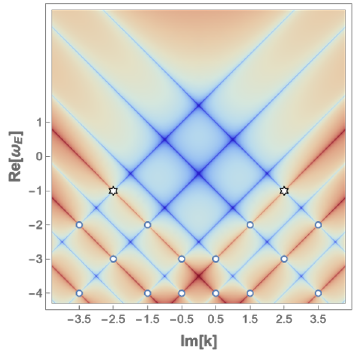
Figure 2 . log jG (cid:1) ( ! E ; k ) j : logarithm of the Fourier transformed conformal two point functions of scalar (cid:12)elds (3.13) for d = 4 ; (cid:1) = 4 : 5. The blue lines represent the zeros and the red lines represent the poles of the two point function so that the intersections between the red and blue lines are pole- skipping points, which are marked as white stars (leading points) and circles (sub-leading points). The numerical values of these points agree with the